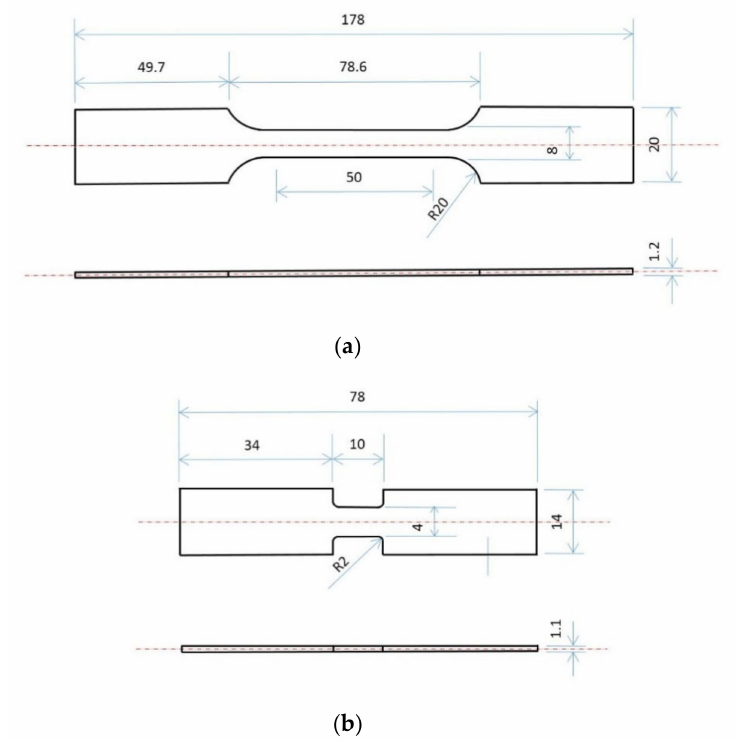
Figure 3. Tension samples used for ( a ) quasi-static and ( b ) dynamic tests. (Units: